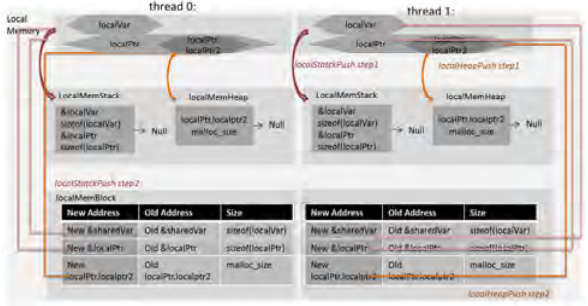
Fig. 8. Process Layout of Local Memory